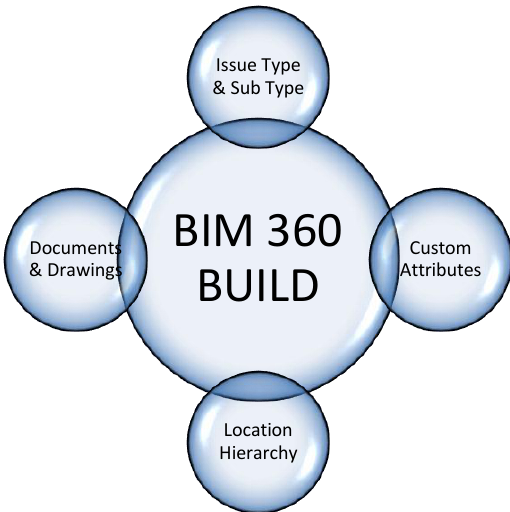
Figure 8: Stages of Issue Template in BIM 360